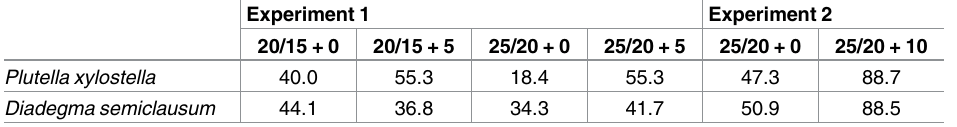
Table 2. Survival rate (%) of P . xylostella and D . semiclausum under the different temperature treat- ments in experiments 1 and